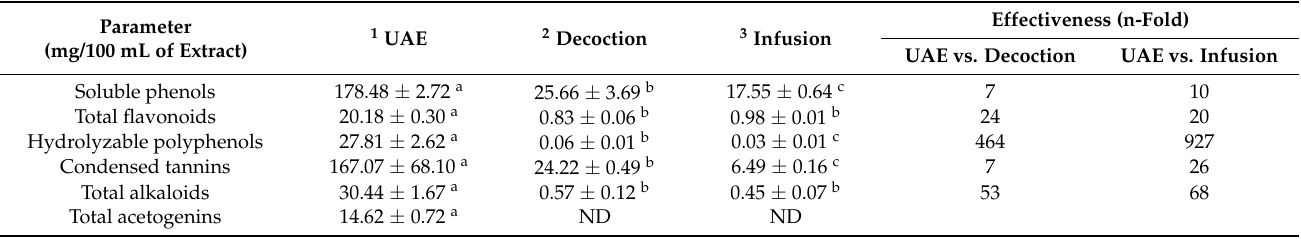
Table 3. Phenolic compounds, total alkaloids, and total acetogenins obtained by optimal conditions of ultrasound-assisted extraction (UAE), decoction, and infusion from extracts of Annona muricata leaves and UAE